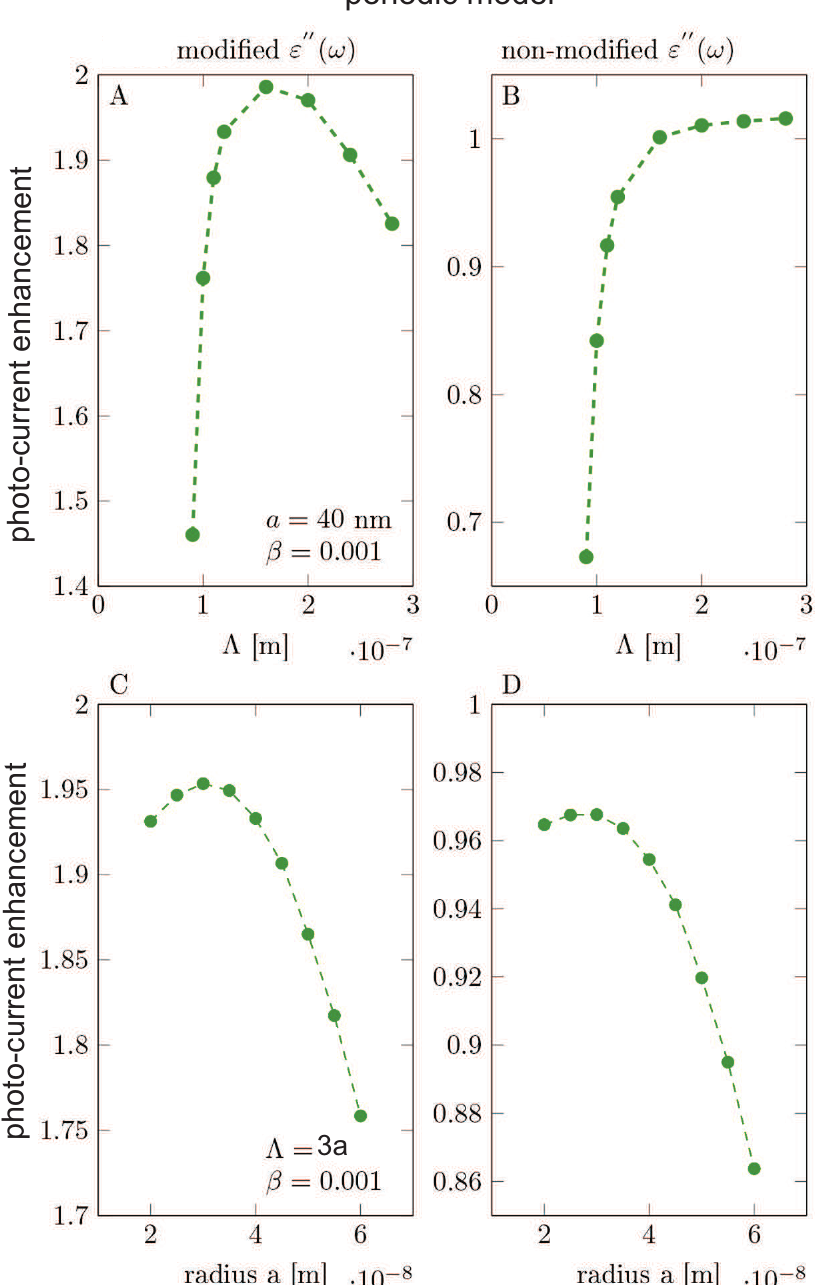
Figure 11. The periodic model ( A , B ): The photocurrent enhancement acc. to Equation (28) as a function of MNP array period. The radius of the MNP is assumed as a = 40 nm. ( C , D ): The photocurrent enhancement as a function of MNPs radius. ( A , C ): Results obtained in the model using modified ′′ ( ε ω ) . ( B , D ): Results obtained in the model using non-modified dielectric function taken from the measurement in bulk [42]. We used the solar spectrum